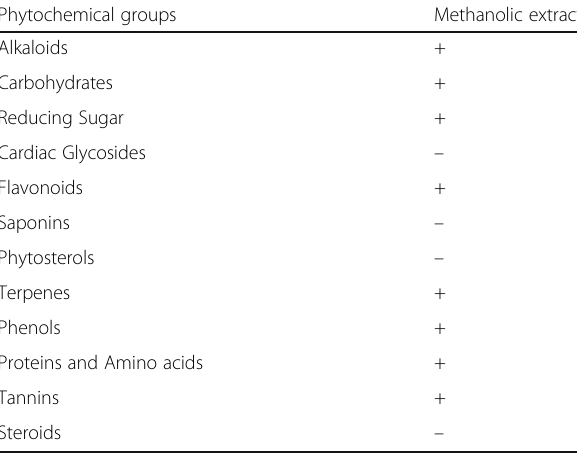
Table 2 Phytochemical compositions of methanolic extract of L. sativus L.